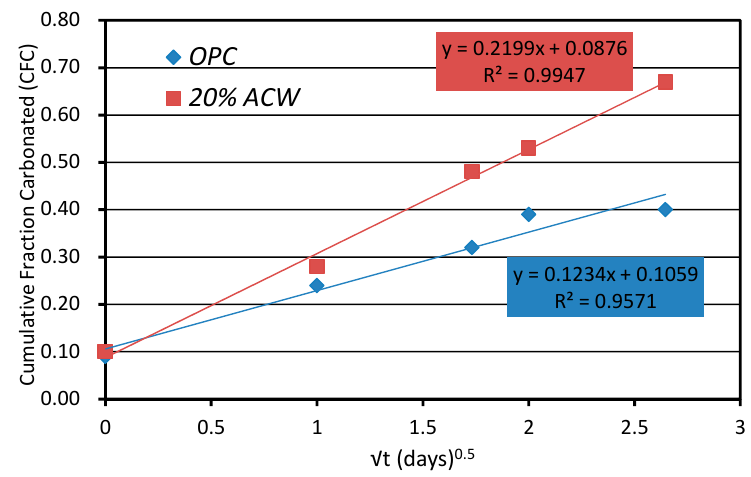
Figure 8. Cumulative fraction carbonated (CFC) content vs. square root of time.